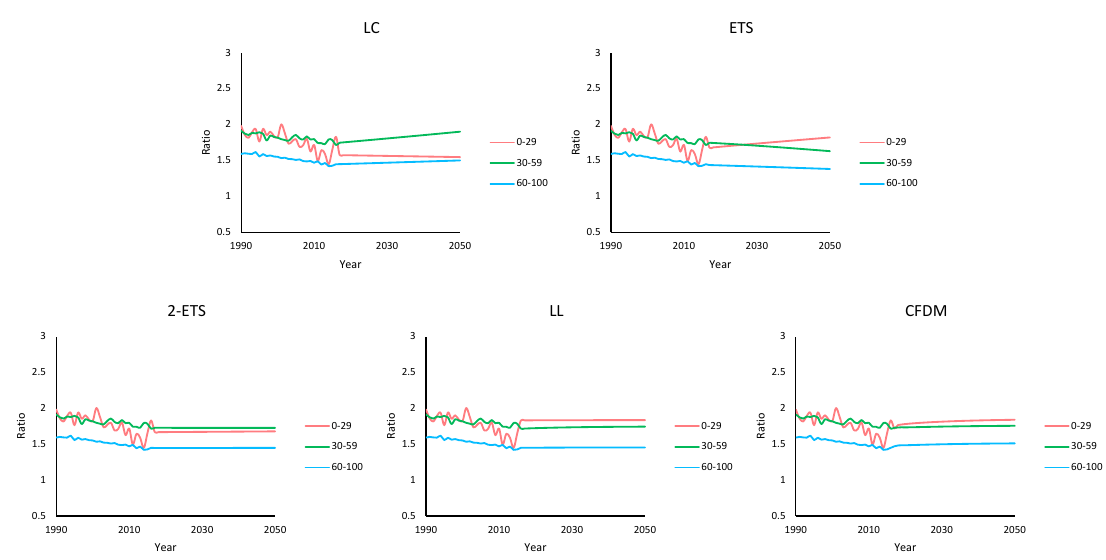
Figure 9. Observed and projected male-to-female ratios of mortality rates for